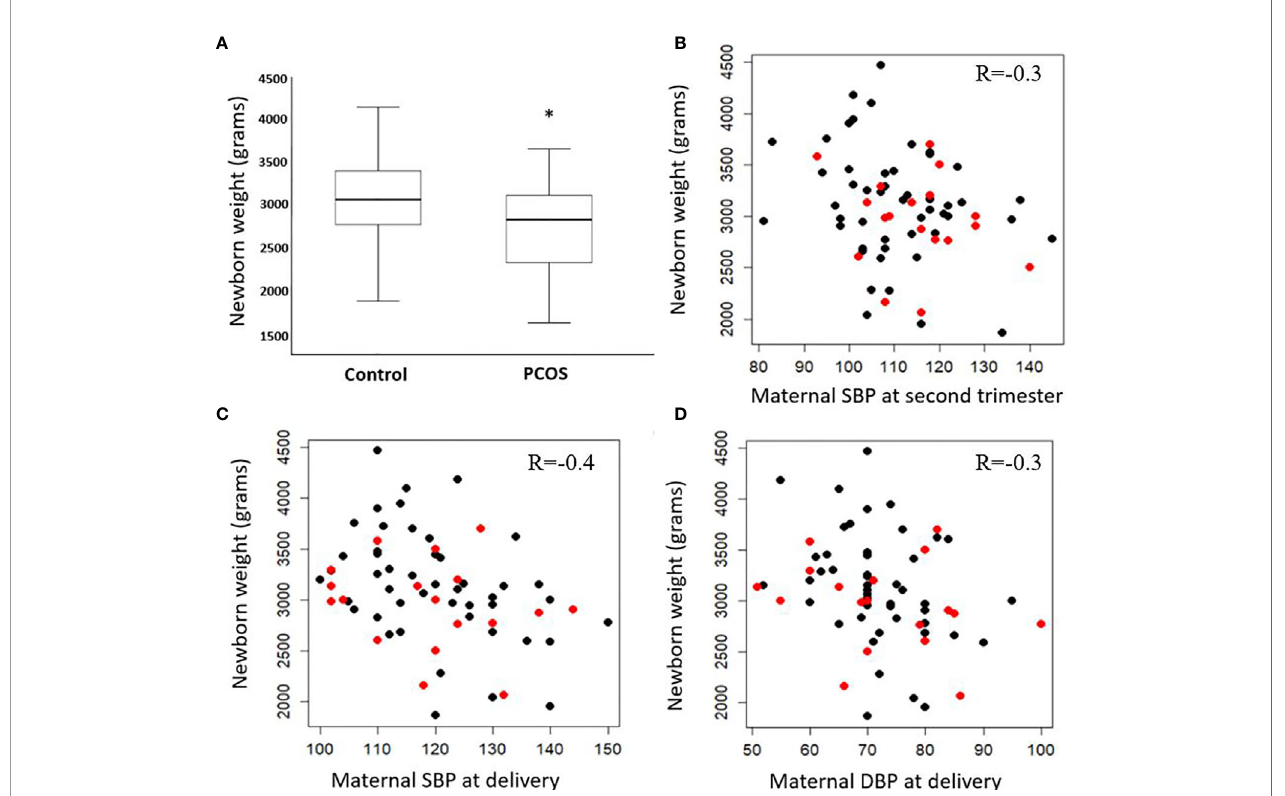
FIGURE 1 | Difference in birth weight at delivery in control and PCOS groups (A) median, interquartile range and maximum and minimum values). Correlations between birth weight (PCOS in red, controls in black) and systolic blood pressure (SBP) of mothers at second trimester (B) , SBP at delivery (C) , and diastolic blood pressure (DBP) at delivery (D) . Signi fi cance level (*) ≤